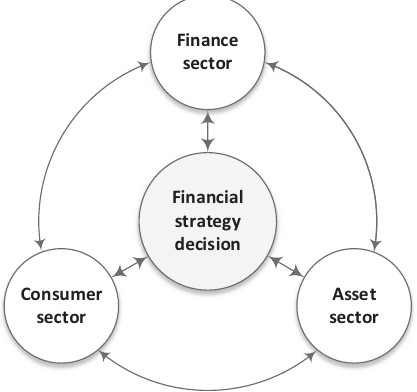
Figure 1. Framework showing the key interactions in a system dynamics